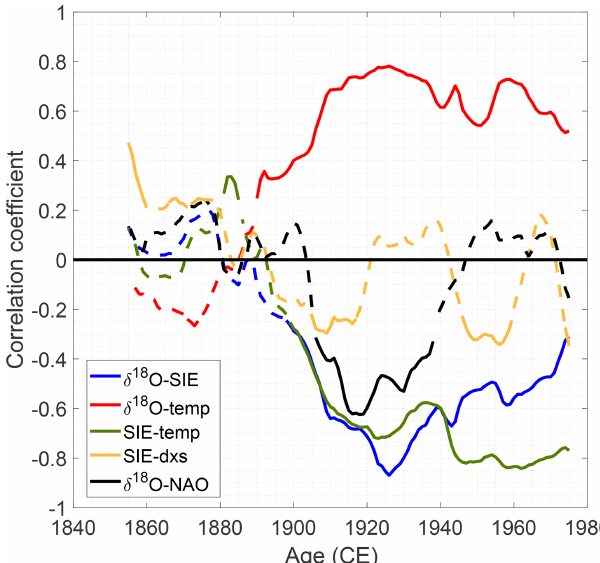
Figure 10. Running correlations of 50 years between Stykkishól- mur temperature and the δ 18 O stack (red), SIE and the δ 18 O stack (blue), SIE and Stykkishólmur temperature (green), the δ 18 O stack, and the NAO index (black) and d xs with SIE (yellow). The solid lines represent significant correlation ( p < 0 . 05), while the dashed lines are insignificant p > 0 . 05. Each year represents the midpoint of the running